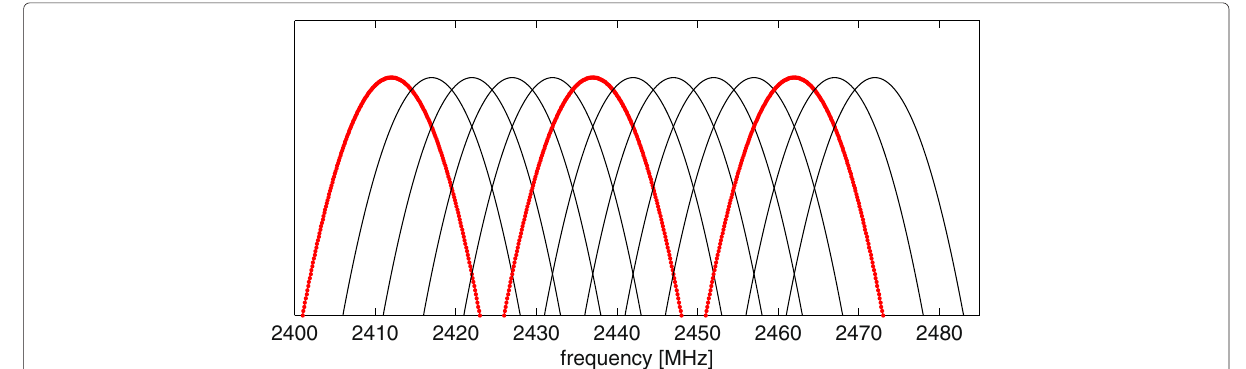
Fig. 7 Example of partial isolation which exists in IEEE 802.11b (ETSI regulatory domain; based on [88]). Each parabola shows range of single channels band. Red marked channels are pairs isolated, but another pairs (i.e., two left most channels) are